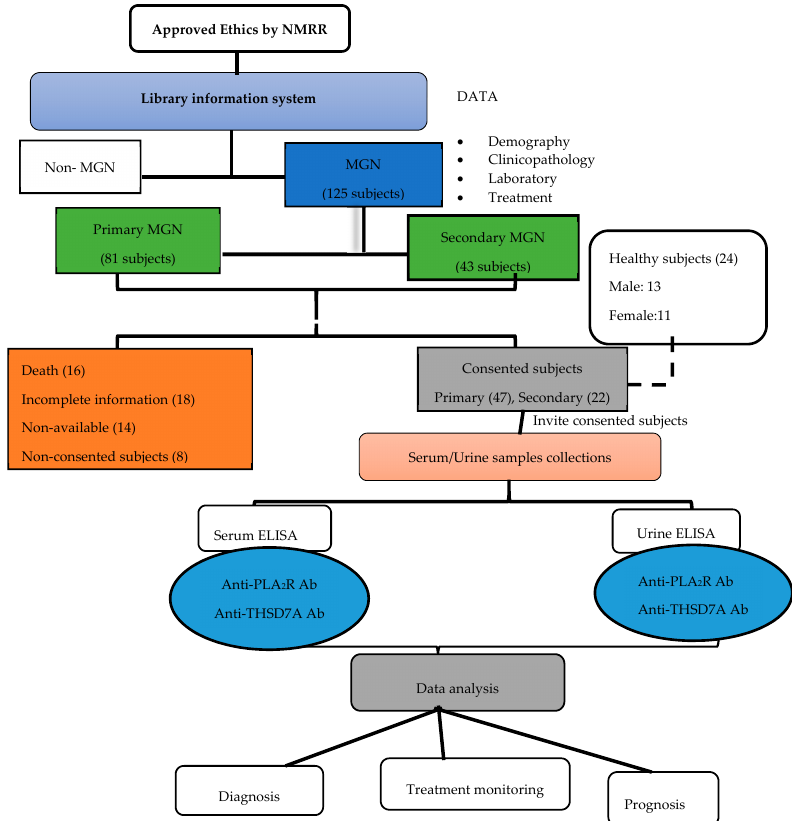
Figure 1. Flow chart of events from ethical approval to data analysis.